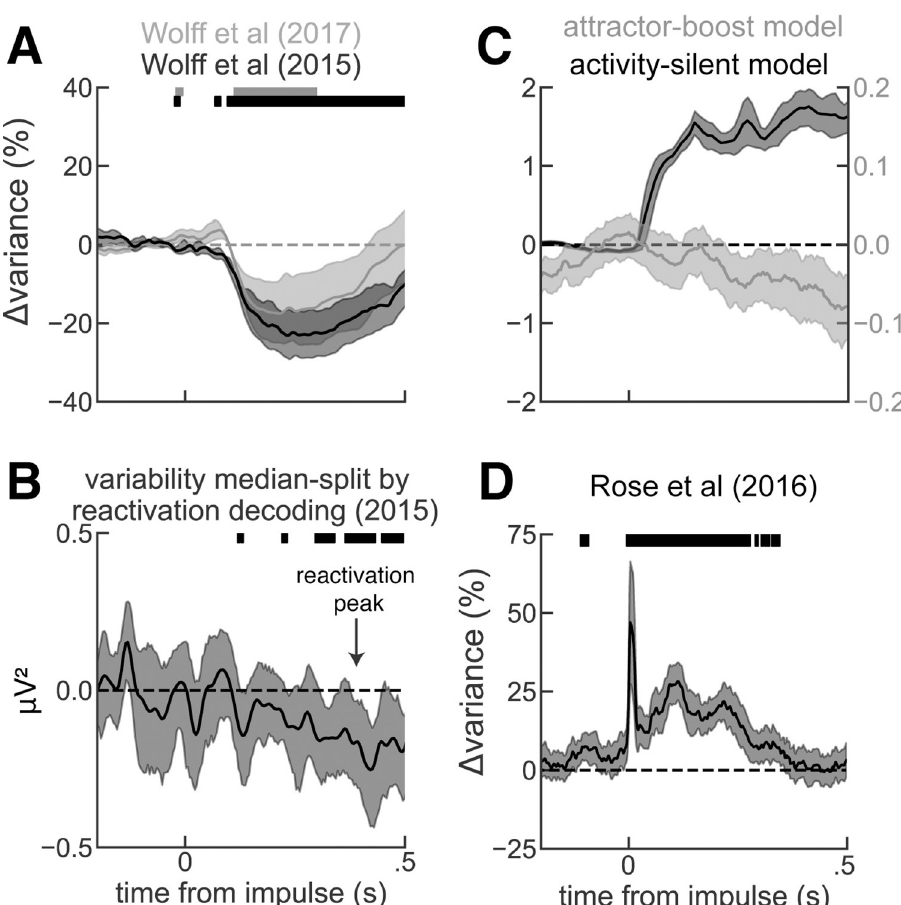
Fig 4. Impulse-induced, across-trial variability change in human EEG and computational models. ( A) Percentage of variability change, relative to 0.2 s before the impulse, computed when the impulse was a visual stimulus in Wolff and colleagues (2017) [7] in gray and Wolff and colleagues (2015) [18] in black. ( B) Difference in variances computed across trials with low vs high stimulus decoding (computed at the time of maximal decodability, black arrow) in Wolff and colleagues (2015) [18]. Trials with strong memory decoding showed significantly lower across-trial variance than trials with weak or absent memory decoding. We did not find a significant correlation in Wolff and colleagues (2017) [7] possibly because of a weaker pinging stimulus, which may have contributed to weaker increase in EEG decodability, not visible without baselining the data during the delay period (see S3 Fig). ( C) Simulations of the activity-silent working memory model with short-term plasticity (dark) predict an increase of across-trial variability (Fano factor) following reactivations induced by a nonspecific drive. Simulations of the bump-attractor model without short-term plasticity (light) predict a decrease in the Fano factor following a nonspecific drive. See also S3 Fig. ( D) Same as (A) but when the impulse was a single-pulse TMS (data from Rose and colleagues, 2016 [6]). Solid bars mark where the change in variability was significant (two-sided t test, p < 0.005), and error bars are bootstrapped 95% CI of the mean. Six out of 54 sessions had outlier TMS artifact variance (i.e., extremely high variance at the time of the impulse) and were removed from this analysis. EEG, electroencephalography; TMS, transcranial magnetic